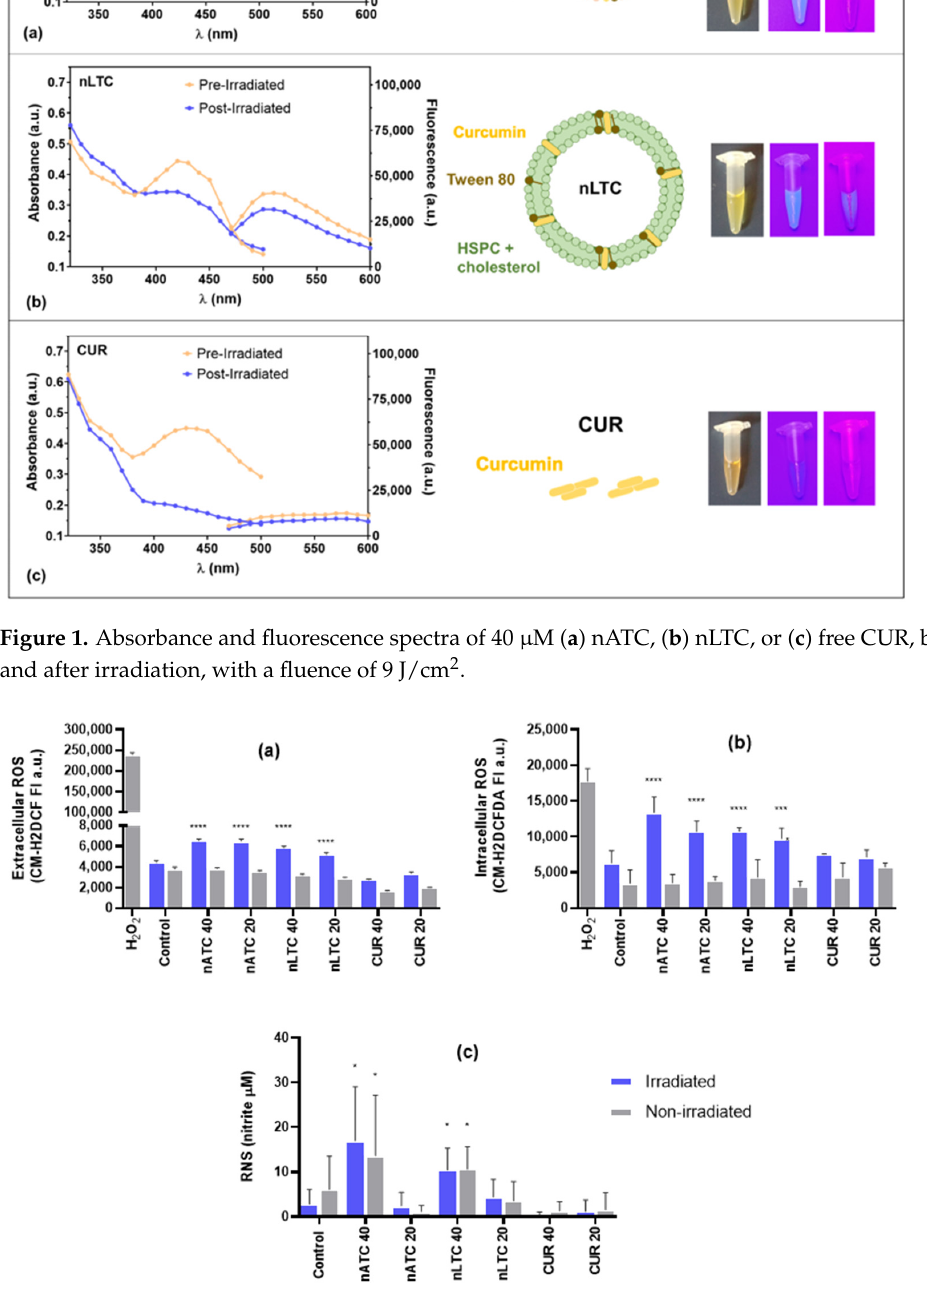
Figure 2. ROS and RNS production by PDT. ( a ) ROS production by irradiated (fluence of 9 J/cm 2 ) or non-irradiated nATC, nLTC and free CUR, suspended in culture medium (RPMI 5% of FBS). ( b ) Intracellular ROS and ( c ) RNS production by A549 cell line after 24 h incubation with irradiated (fluence of 9 J/cm 2 ) or non-irradiated nATC, nLTC or free CUR. Statistical significance compared to non-irradiated control was determined using a one-way ANOVA followed by Dunnet’s test, * p < 0.05; *** p < 0.001, **** p < 0.0001.